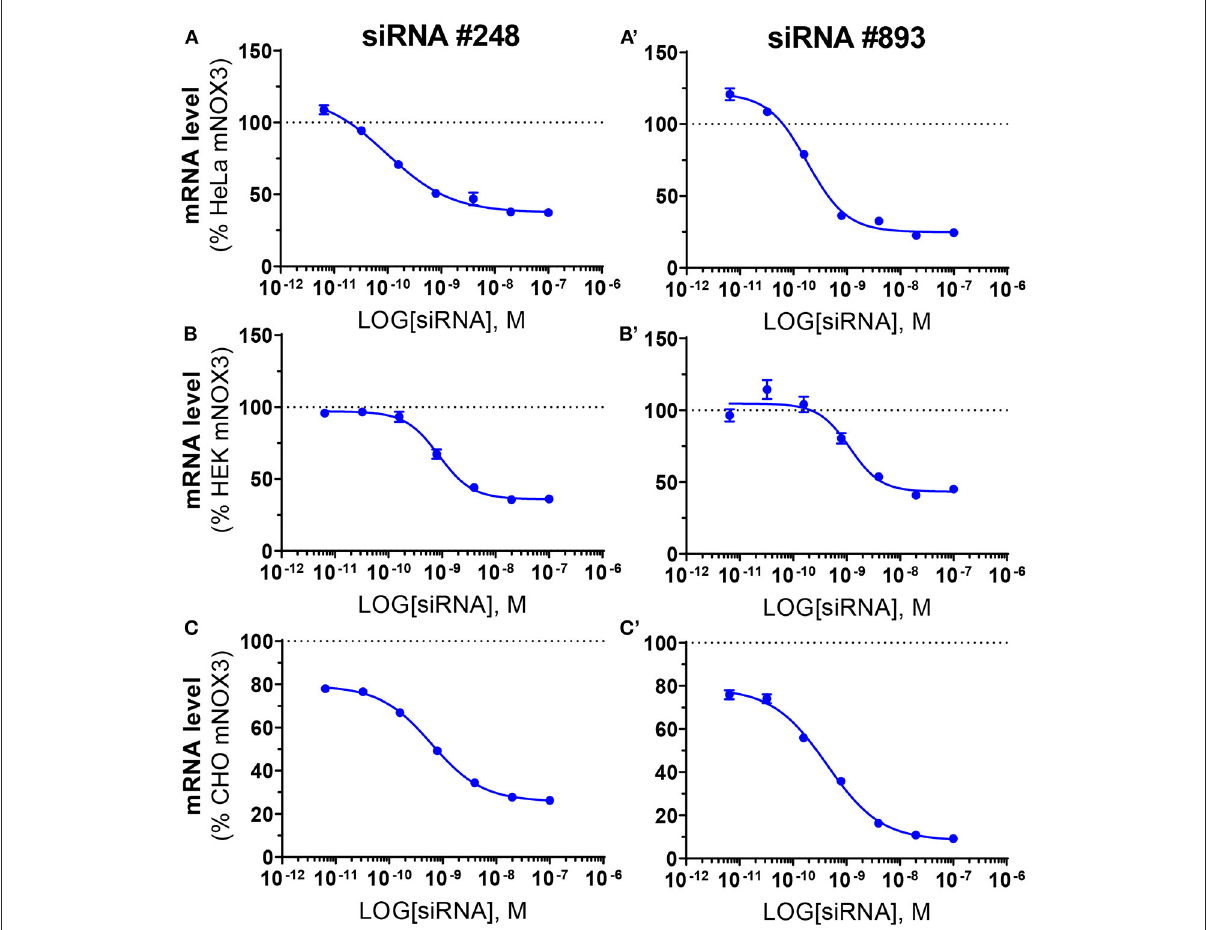
FIGURE3 Validation of the efficiency of siRNA #248 and #893 on Nox3 mRNA level in three mNox3 expressing cell lines. NOX3 mRNA measured by qPCR in NOX3 expressing (A) HeLa, (B) HEK and (C) CHO transfected with increasing concentrations (100–0.0064nM) of siRNA #248 (A–C) and #893 (A’–C’). siRNA concentrations are represented as the logarithm of the concentration (M). NOX3 mRNA expression was normalized to non-transfected cells. Data represent the average of three independent experiment + - SEM.